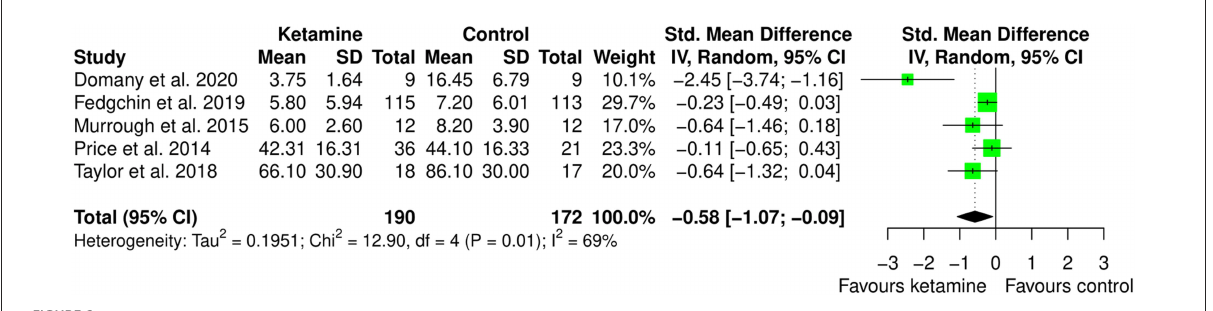
FIGURE6 Subgroup meta-analysis of anxiety among ketamine/esketamine and control groups. SD, standard deviation; IV, inverse variance; 95% CI, 95% confidence interval. x axis labels have been edited according to the characteristics of the outcome: since lower scores indicate less anxiety the label “Favors ketamine” is on the left-hand side.